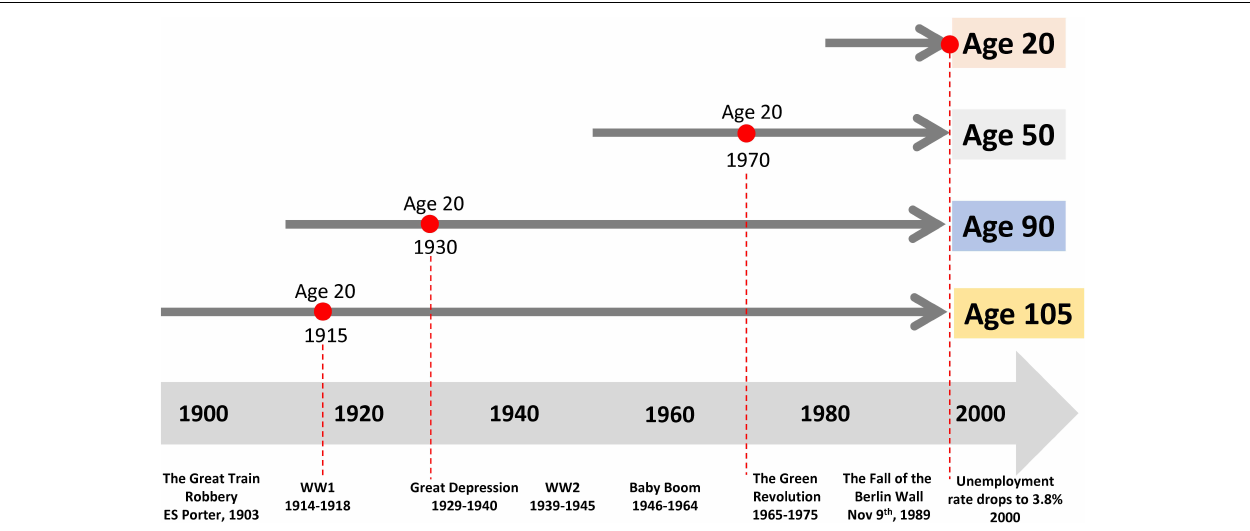
FIGURE 1 | Past exposure to different environments affects the trajectories of aging and may bias the interpretation of cross-sectional studies. Let us assume that an investigator wants to compare individuals of different ages, such as 20, 50, 90, and 105. These individuals were 20 years old in very different historical epochs, which are as far apart as 85 years, characterized by extremely diverse access to food, stress, pollution and many other characteristics. Here, age- differences are indistinguishable from differences due to very different historical